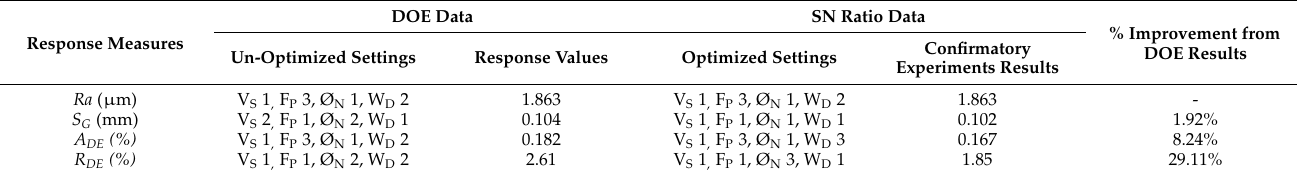
Table 6. Mono-objective optimized confirmatory